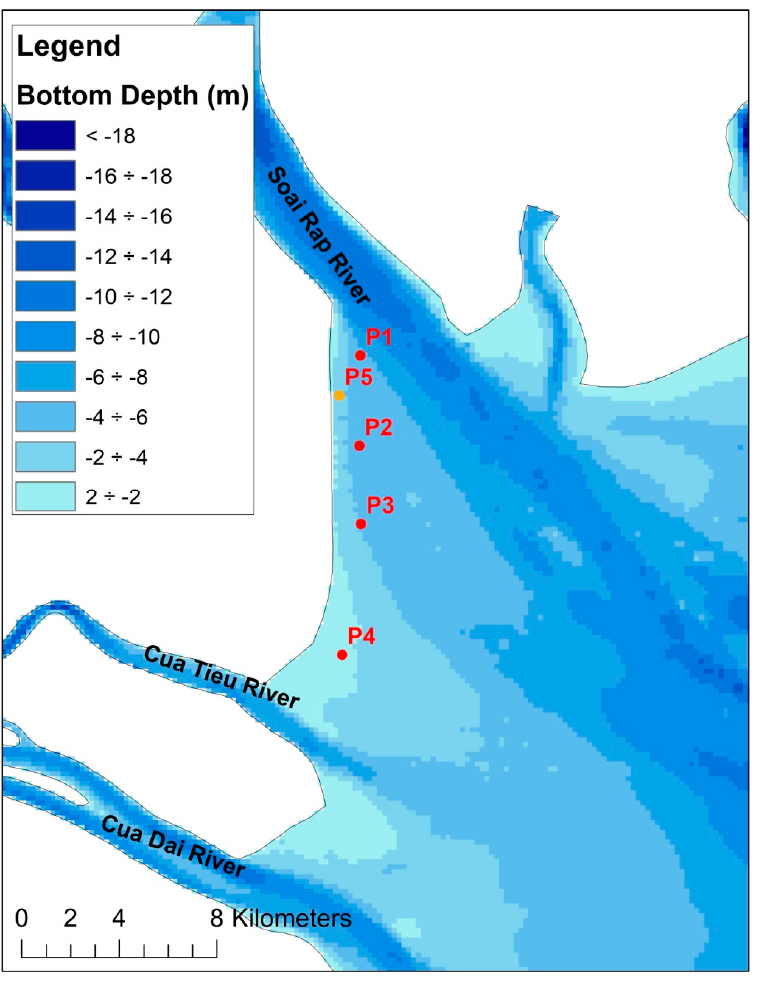
Figure 7. Locations of model output points in the Go ‐ Cong Coastal Zone. According to the numerical results, currents in the Soai ‐ Rap and Cua ‐ Tieu Estuaries and their adjacent coastal zone are strongly dominated by tides. In the Go ‐ Cong Coastal Zone, they can reach up to 1.35 m.s − 1 oriented toward the north and northeast in the ris ‐ ing tide and 1.65 m.s − 1 toward the south and southeast in the falling tide. The magnitude of currents in the SW monsoon is higher than that in the NE. Figures 8 and 9 show wave rises at P1, P2, P3, and P4 in the NE and SW monsoons of 2014. Note that the significant wave heights in the NE monsoon are much higher than in the SW monsoon. In the SW monsoon, the probability of significant wave heights < 0.1 m is over 90%, while, in the NE monsoon, it is only about 10% to 25%. The probability of significant wave heights of 0.2 m is less than 2% in the SW monsoon, while it can reach up to 40% in the NE monsoon. The differences between NE and SW conditions cannot be attributed to river flow because two main forcings in this study are tides and monsoon winds. River flow influence is weak compared with these two forcings.